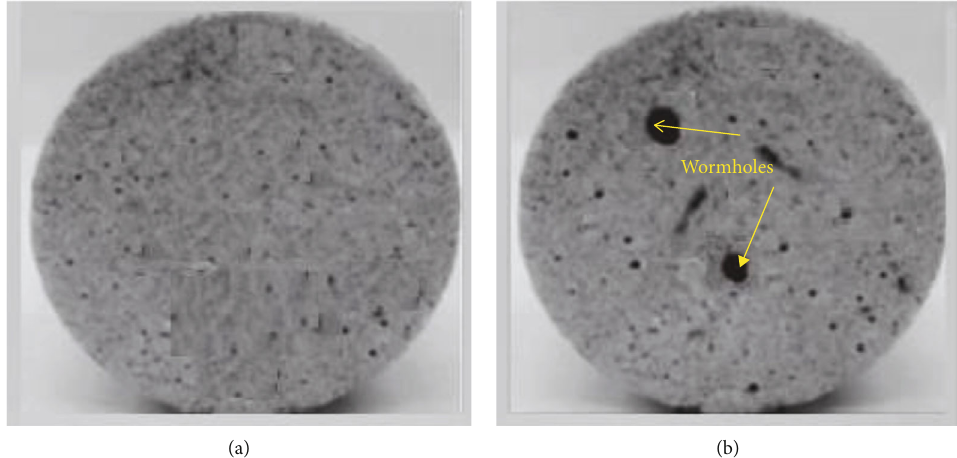
Figure 9: Core sample for core fl ooding. (a) Sample before fl ooding. (b) Wormholes after injecting the new